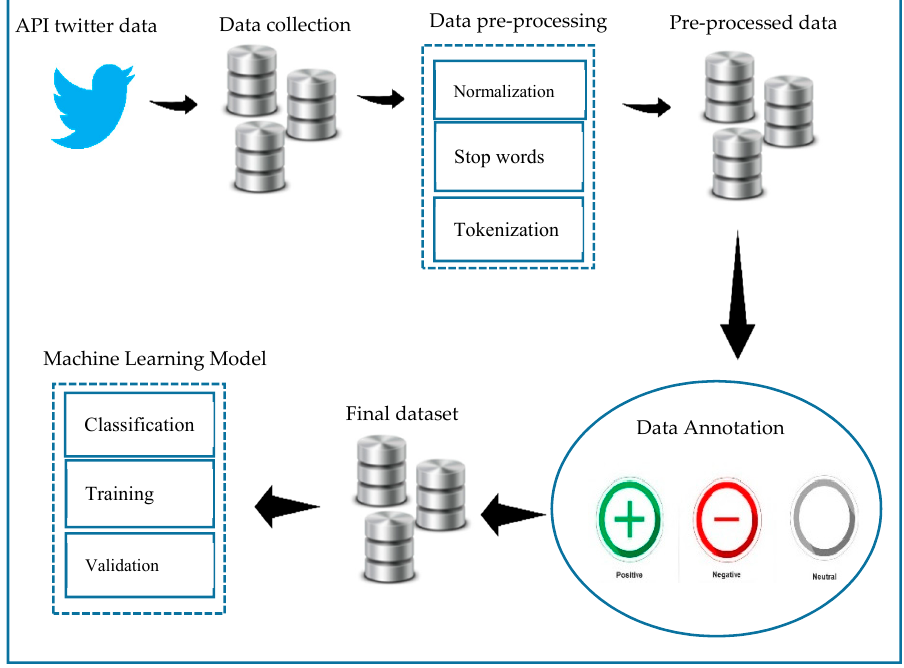
Figure 1. The framework for awareness prediction sentiment analysis approach.